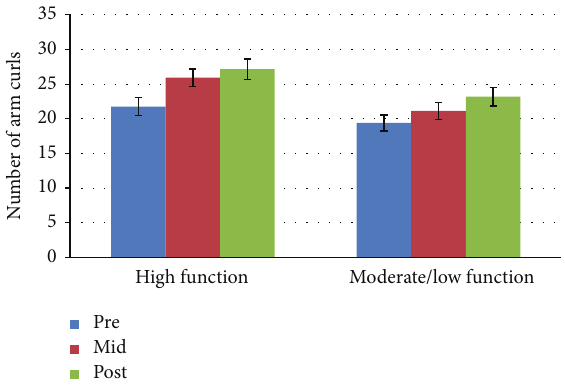
Figure 2: Arm curl test mean scores by group and